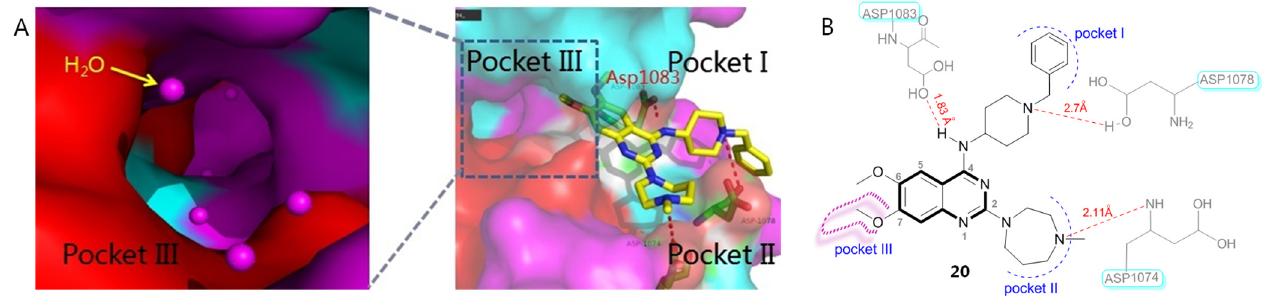
Figure 6. ( A ) Crystal structure of three active binding domains in HMT (PDB code: 3K5K) and ( B ) binding mode of BIX01294 (20) with HMT. ( B ) binding mode of BIX01294 (20) with